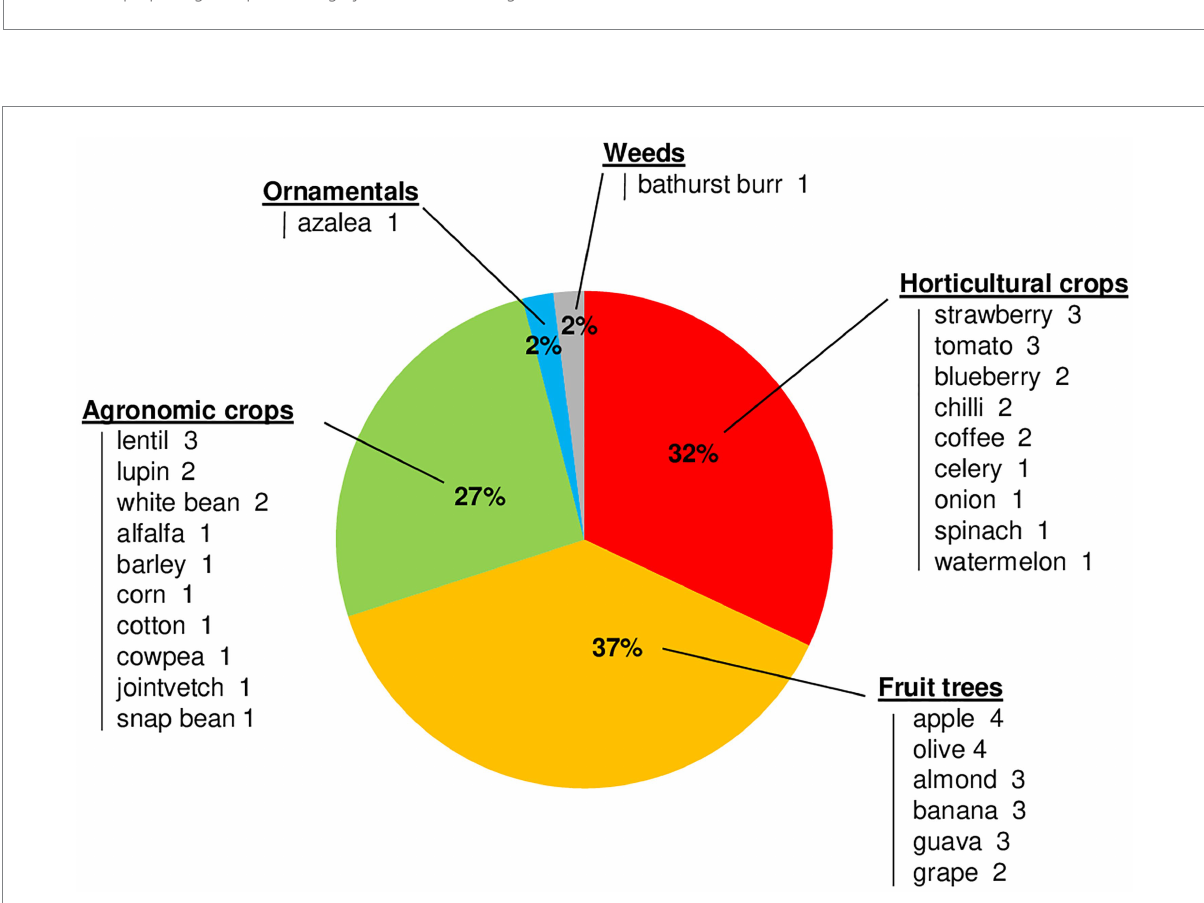
FIGURE 6 Percentages of the papers that evaluated the influence of temperature on conidial infection on different host crops grouped by crop type. Hosts are listed under each crop type, with the number of papers in which they were tested for conidial